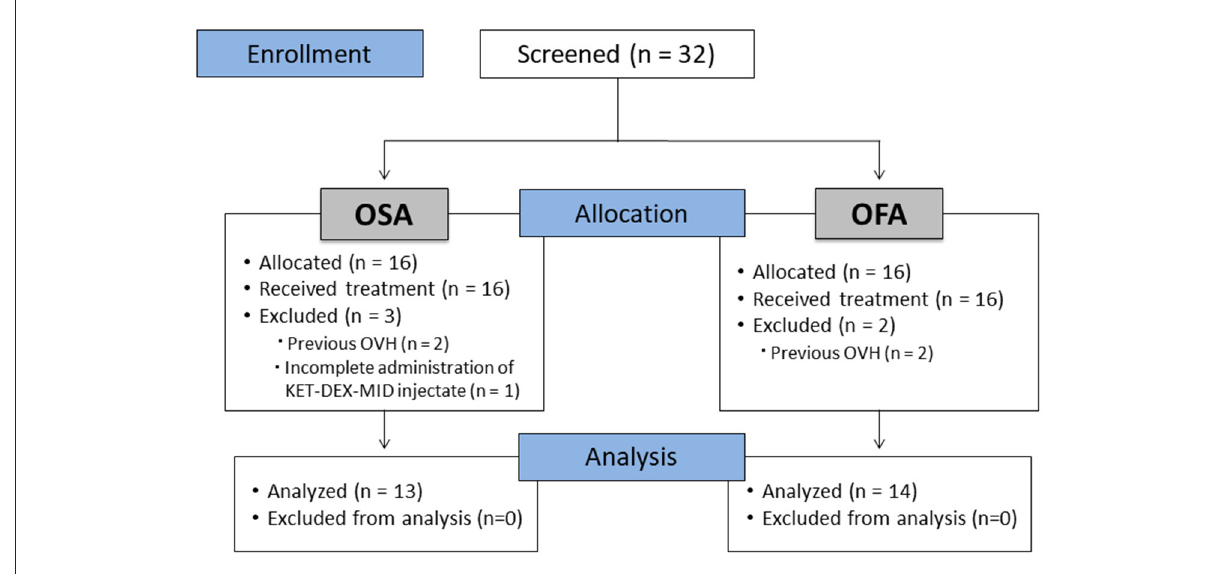
FIGURE1 CONSORT flow diagram. OFA: Opioid-free anesthesia group; OSA: Opioid-sparing anesthesia group; OVH: Ovariohysterectomy.